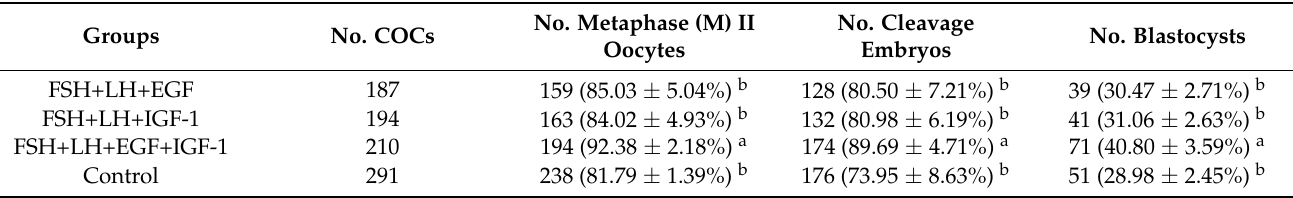
Table 2. Effect of EGF and IGF-1 on the maturation and development ability of bovine oocytes.